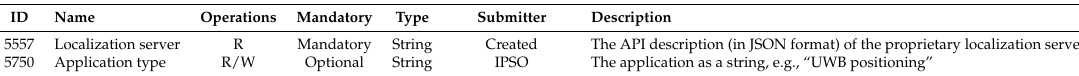
Table 5. Localization server object based on LwM2M/IPSO (Object ID